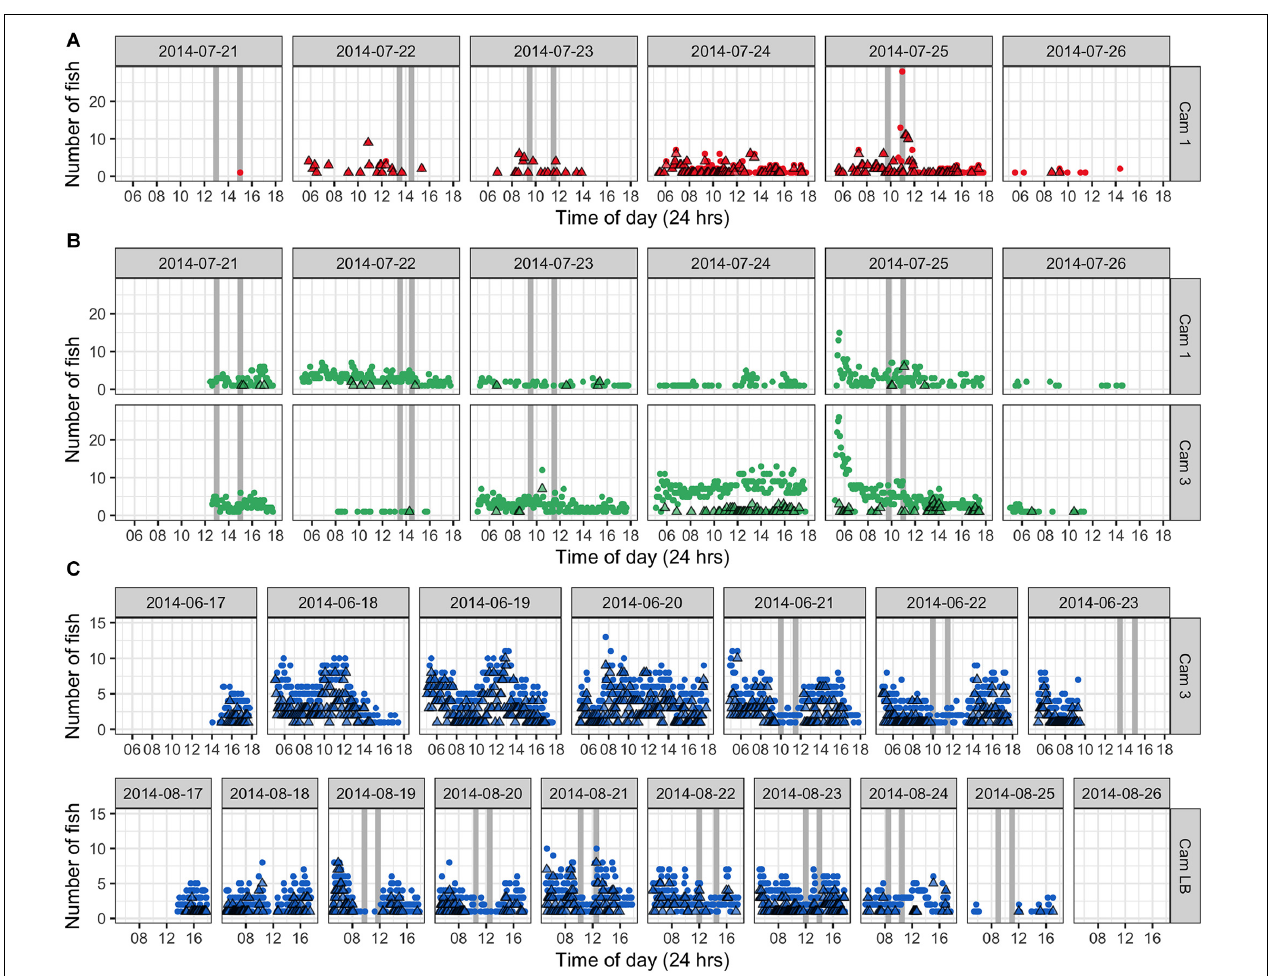
FIGURE 10 | Number of fish counted in images taken with time-lapse mode camera operation in 2014 at selected locations within the Ebiil study site. Circles represent benthic and midwater counts combined, while triangles indicate midwater counts only. Vertical gray bars represent dive survey times (two dives per day). (A) P. areolatus July 21 to 26, 2014; peak abundance for that month was July 25 (although no dive was possible on 24th) ; (B) E. polyphekadion . Two cameras (Cam 1 and 3) located in different areas of the survey site recorded from July 21–26th, peak abundance was on July 22. (C) E. fuscoguttatus prior to and during the June survey period, but camera battery ran out at 10 am on June 23rd, a day before the peak abundance. In August 2014, peak abundance was on August 22 with fish leaving the site on the